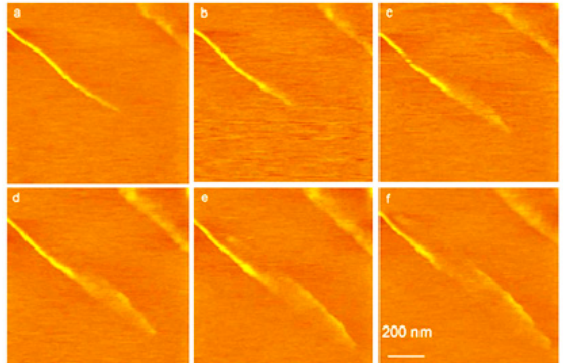
Figure 6. Real-time AFM phase images showing continuous lamellar twisting of poly( R -3-hydroxybutyrate-co-17 mol% R -3-hydroxyhexanoate) from edge-on to flat-on at 85 °C. The time intervals between two consecutive images of ( a – f ) are 6 min. Adapted with permission from Ref. [27]. Copyright (2004) American Chemical Society.